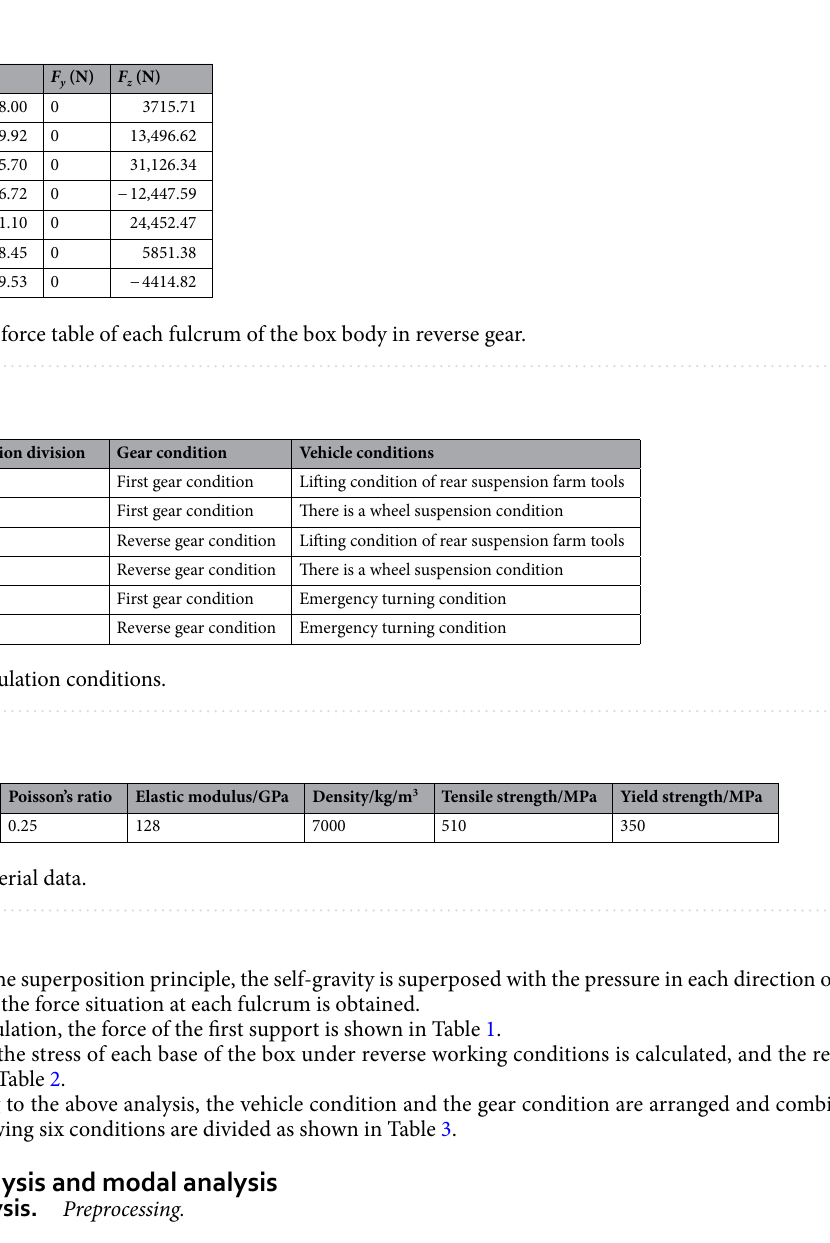
Table 1. Statement of support force of box.